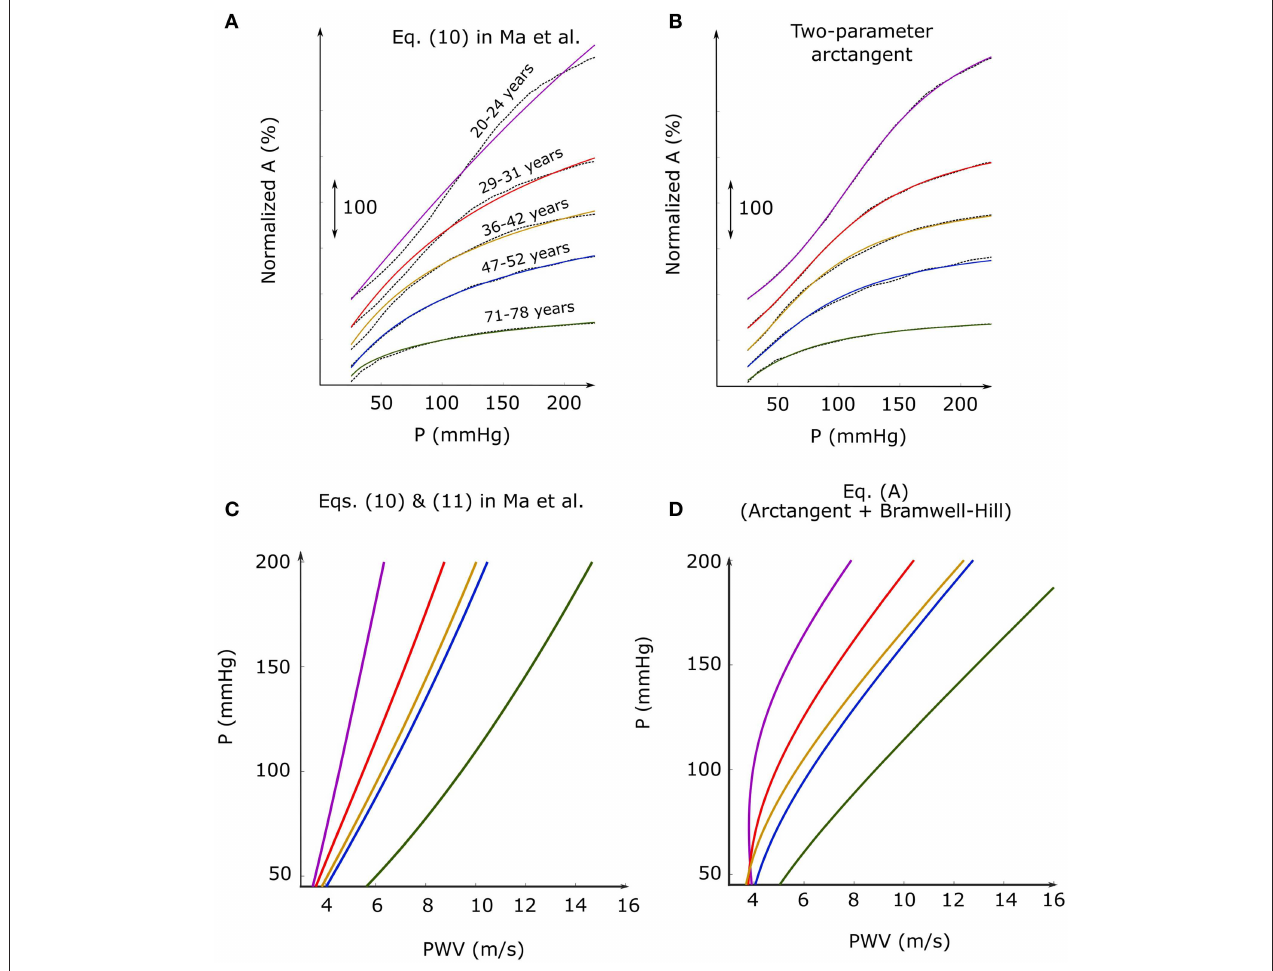
FIGURE 1 | (A,B) Least squares fits of Equation (10) in the article of Ma et al. and two-parameter arctangent (solid-color) to human aortic cross-sectional area (A)-blood pressure (P) data (dash-black) for different age groups ( Hallock and Benson, 1937). (C,D) Corresponding P-pulse wave velocity relations resulting from substituting the above model A-P relations into the Bramwell-Hill equation ( PWV = ( A /ρ )( dP / dA ), where ρ is blood p